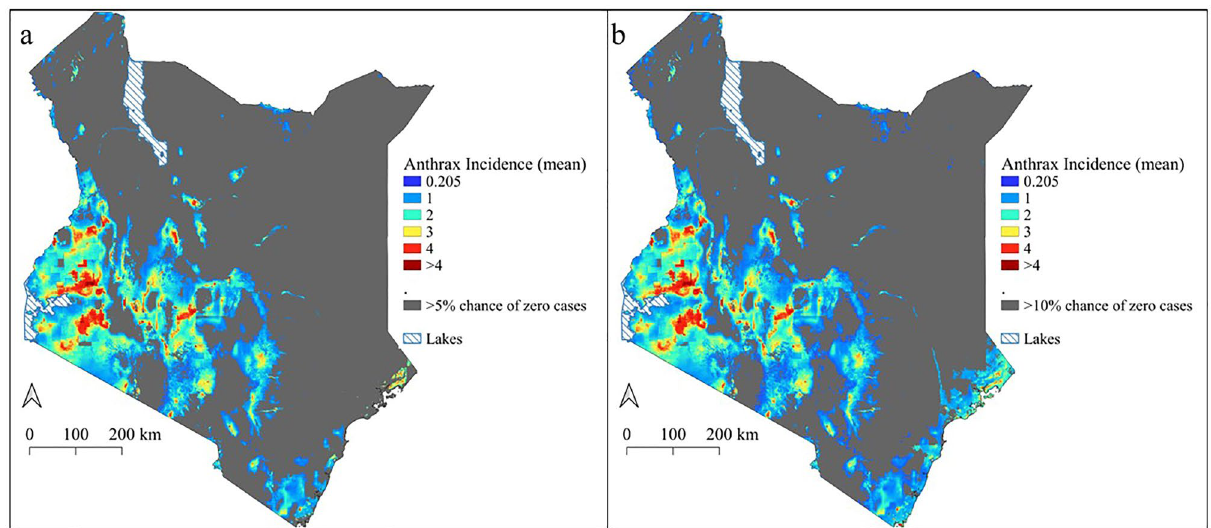
Figure 7. The uncertainty around the slope of the posterior predicted incidence of anthrax disease across Kenya. The grey areas show locations where greater than 5 percent ( a ) and 10 percent ( b ) of the slope of predicted incidence was below the cut-off (0.205) for positivity. We extracted the fitted density distributions of the predicted anthrax incidence and calculated the percentage/proportion of the density distribution that was lower than the positivity cut-off, then greyed out areas that had more than 5% ( a ) or 10% ( b ) of the fitted density below the cut-off. The scale for anthrax incidence shows colours ranging from blue to red, with blue showing areas with low incidence and warmer colours towards red showing areas with higher anthrax incidence. Maps generated using Quantum Geographical Information Systems (QGIS) v. 3.16.11 (https:// www. qgis. org/ en/ site/ forus ers/ downl oad. html).